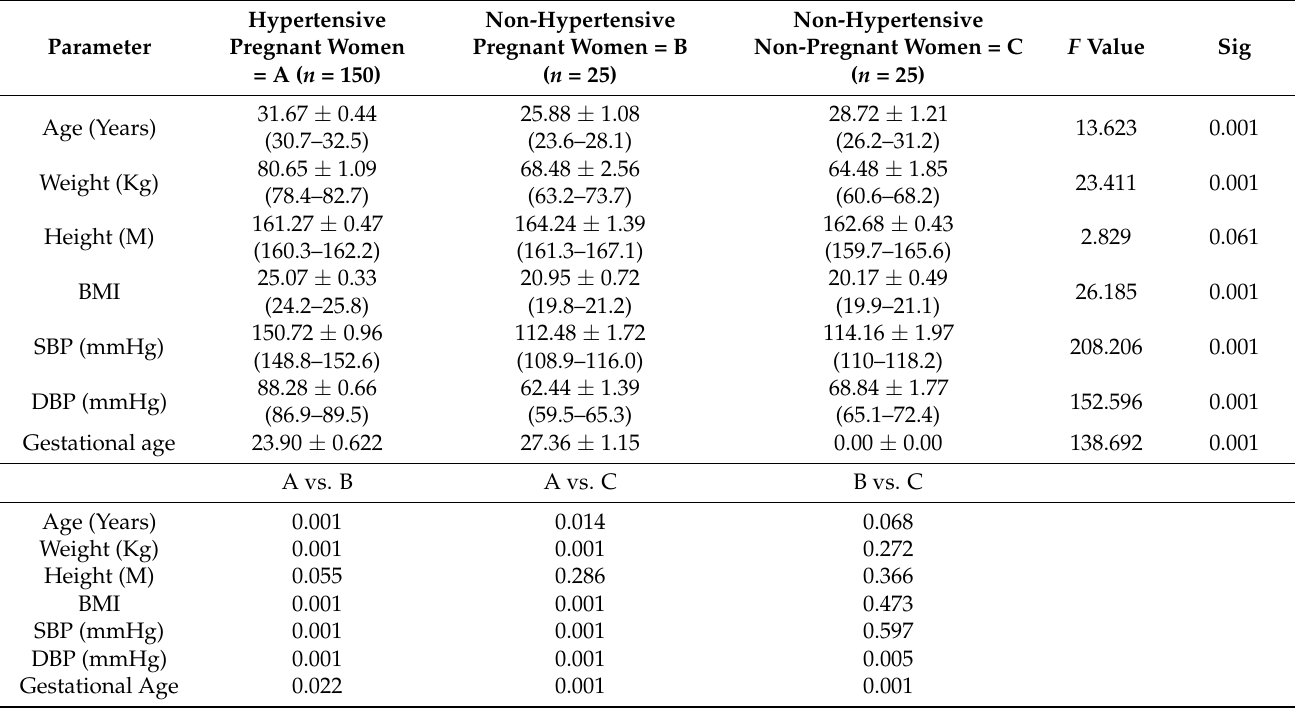
Table 1. Anthropometric measurements of hypertensive pregnant women, non-hypertensive preg- nant women and non-hypertensive non-pregnant